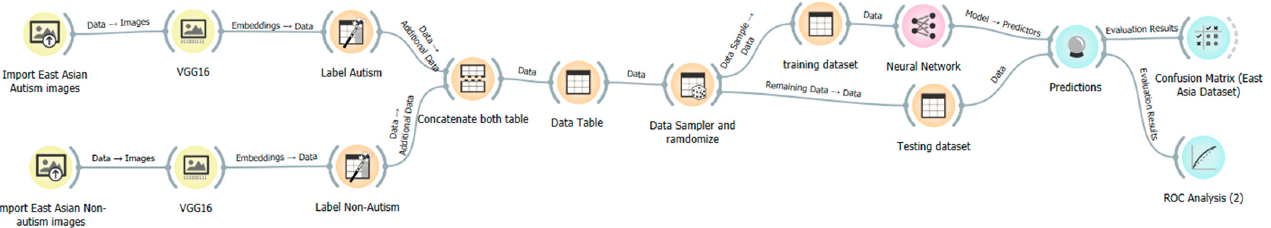
Figure 4. VGG16 transfer-learning-based deep-learning model pipeline architecture for the East Asian dataset training and classifications using the Orange ML platform (screen shot).